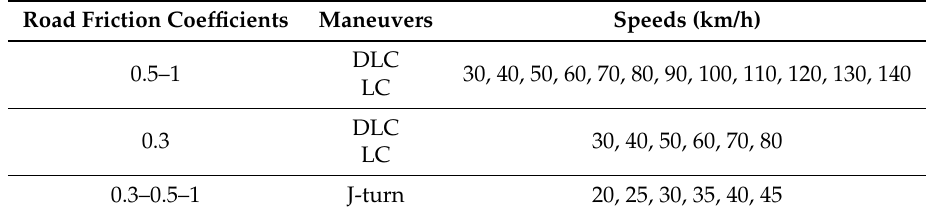
Table 1. Training datasets for NN, DLC, Double Lane Change, LC, Lane Change.